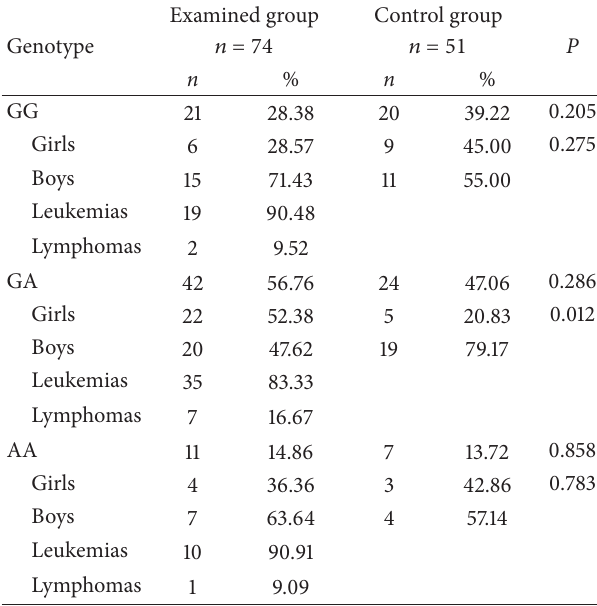
Table 2: Distribution of Q223R